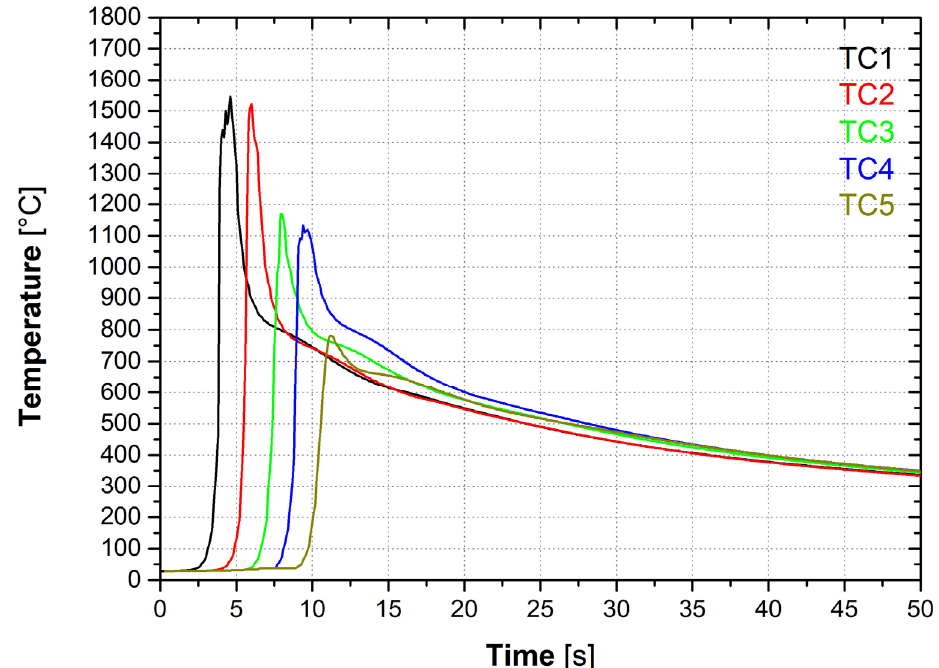
Figure 9. Temperature cycles measured in Weld_14_A.